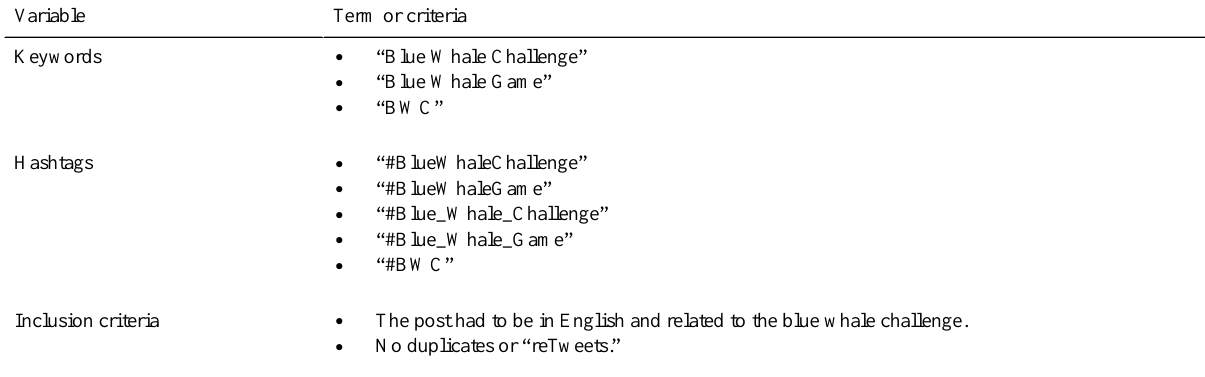
Table 1. Keywords, hashtags, and inclusion criteria for collecting Twitter posts using Radian6. Term or